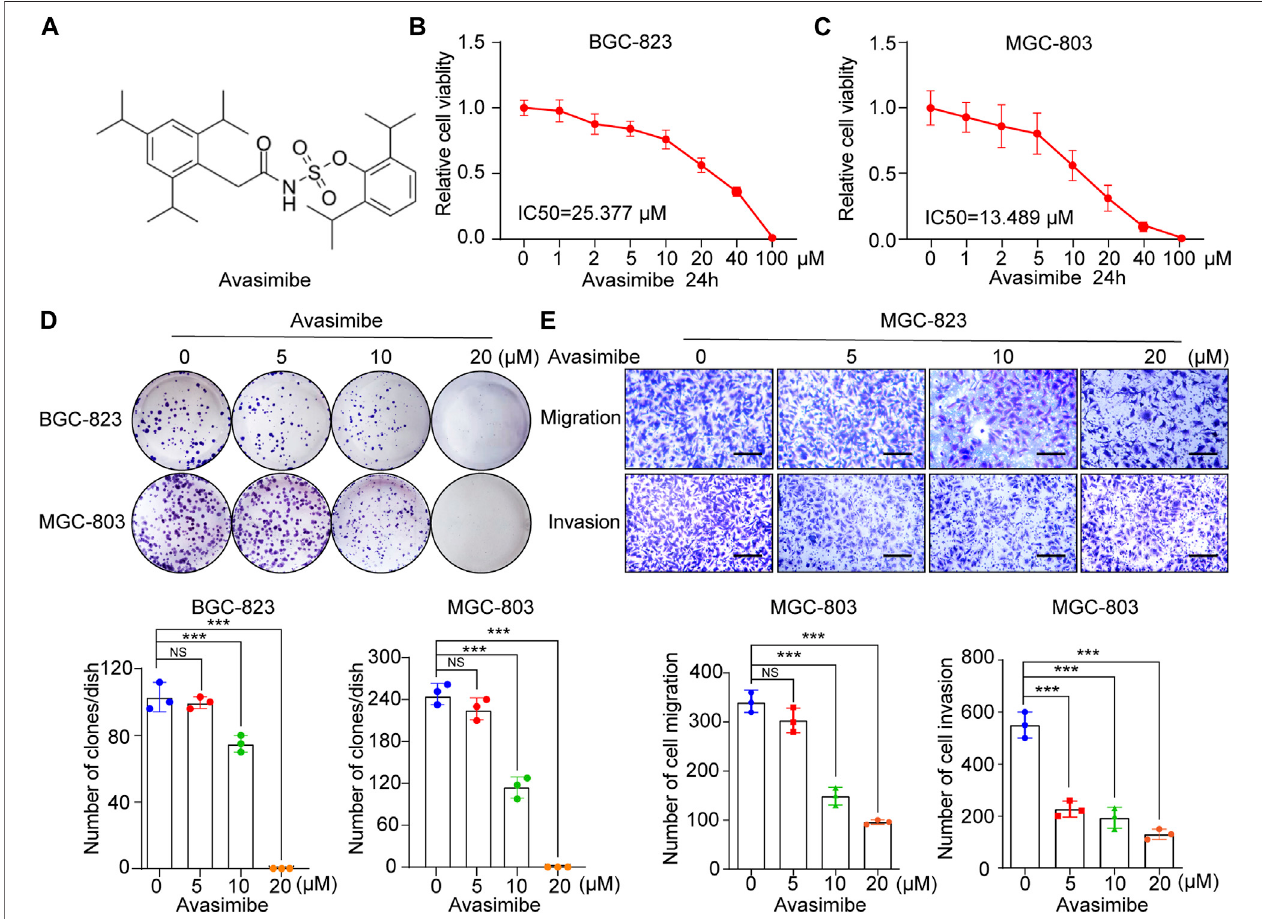
FIGURE4| AvasimibeinhibitsGCcellgrowthandmetastasis. (A) Molecularstructureofavasimibe. (B,C) RelativecellviabilitywasmeasuredbyCCK-8assayafter avasimibetreatmentfor24 hatmultiplyconcentrations(0,1,2,5,10,20,40,and100 μ M). (D) RepresentativeimagesofcolonyformationassayinBGC-823andMGC- 803 cells after avasimibe treatment (upper panel); the quantitative results were shown (lower panel). (E) Transwell assay in MGC-803 cells after avasimibe treatment. Representative images of migrated and invaded GC cells in each group were shown in the left panel, and the quantitative results were shown in the right panel. Scale bars: 100